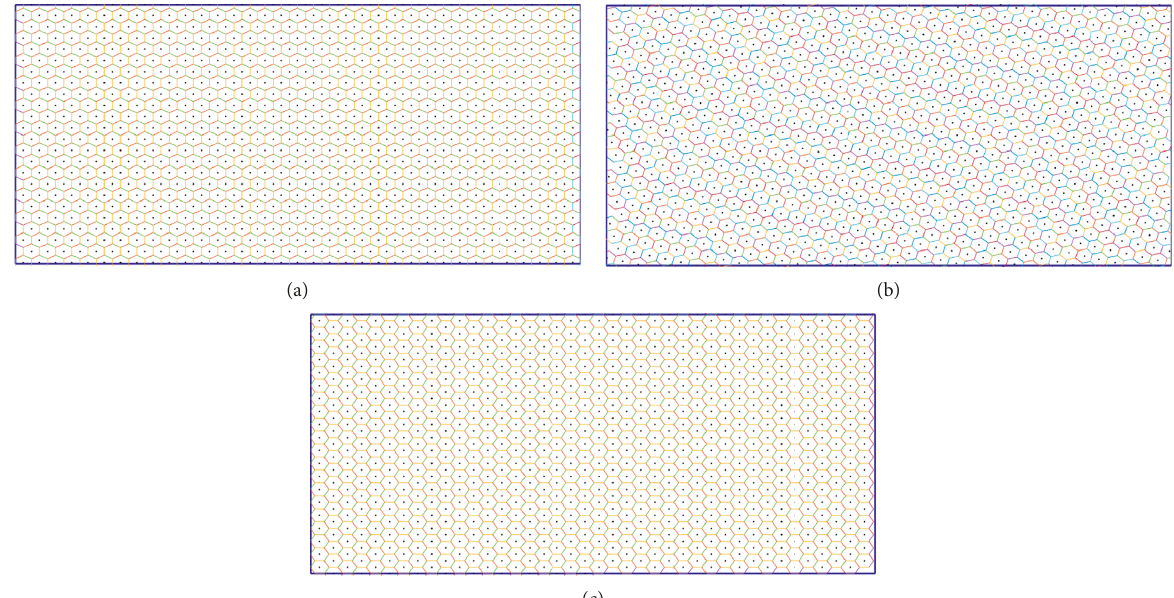
Figure 11: Lattice mesh with different fiber angles. (a) α